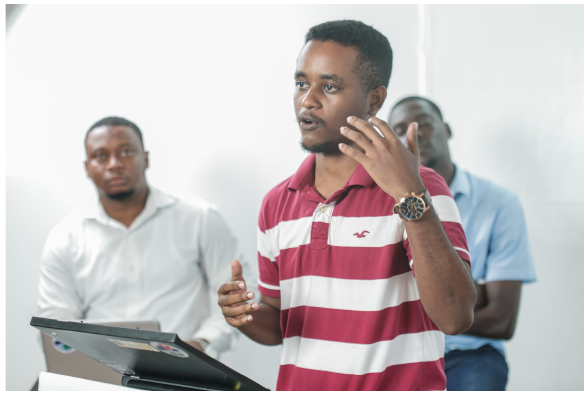
Figure 2. Student during video recording for final pitching in